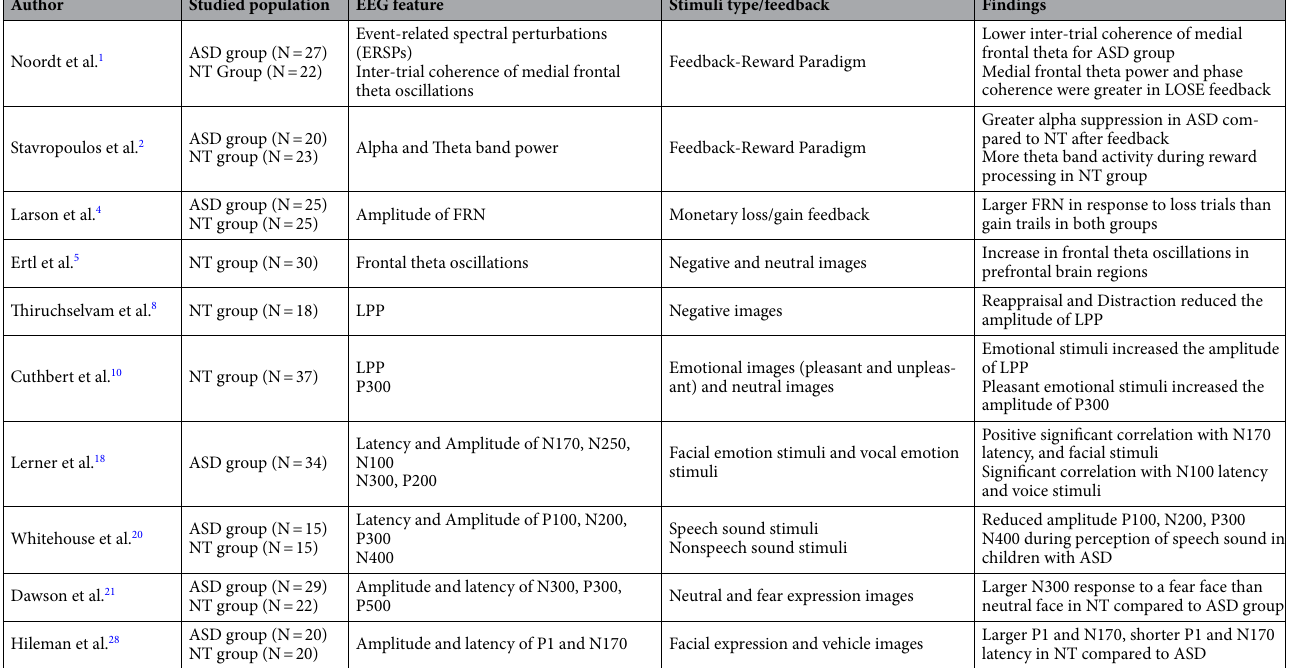
Table 1. Studies of EEG patterns associated with emotional processing and regulation. ASD group: Individuals with ASD, NT group: Neurotypical individuals. N: the number of